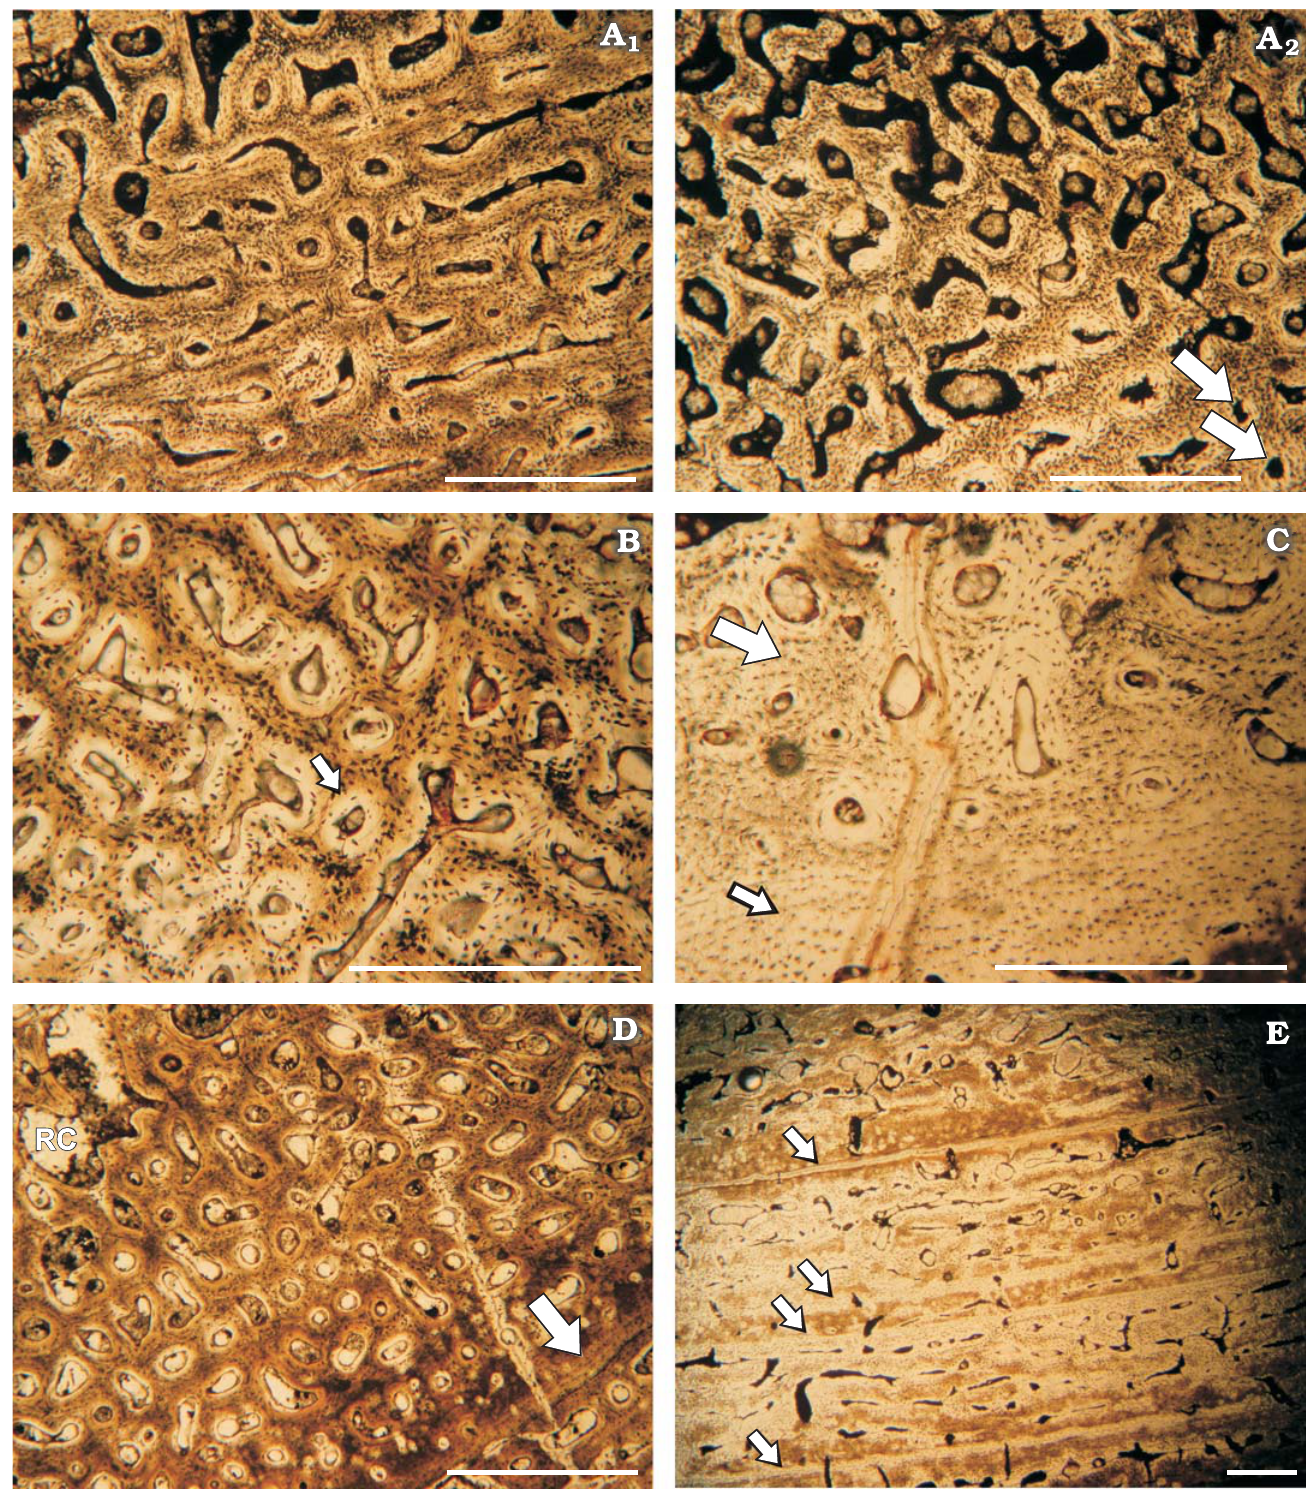
Fig. 2. Transverse section of hyperodapedontine rhynchosaurs Hyperodapedon sp. from Santa Maria Supersequence, Santa Maria 2 Sequence, Rio Grande do Sul, Brazil, Upper Triassic. A . UFRGS-PV-0247-T, tibia showing the fibrolamellar bone tissue in the perimedullary region (A ); humerus showing 1 the fibrolamellar bone tissue with primary osteons (big arrows) (A ). B . UFRGS-PV-1217-T, radius showing uninterrupted fibrolamellar bone tissue with 2 longitudinal oriented vascular canals (arrow). C . UFRGS-PV-0293-T, tibia showing a poorly defined fibrolamellar bone tissue in the perimedullary region (big arrow) and a parallel-fibred bone tissue (arrow) towards the periphery. D . MMACR-PV-018, humerus with resorption cavities (RC) in the perimed- ullary region and a growth mark (big arrow) in the mid-cortex. E . UFRGS-PV-408-T, humerus showing the lamellar-zonal bone tissue with growth marks (arrows). Scale bars 1